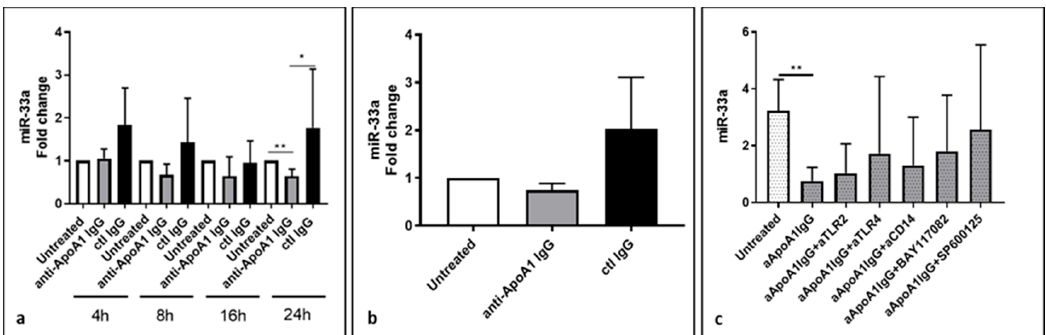
Figure 1. Lower levels of intracellular and extracellular miR-33a in anti-ApoA-1 IgG-treated human macrophage. Cells were treated with anti-ApoA-1 IgG or control antibodies for 4, 8, 16, and 24 h and RT-PCR was performed to determine ( a ) intracellular miR-33a levels as well as ( b ) miR-33a in the supernatant counterpart after 24 h anti-ApoA-1 IgG or control IgG treatment. ( c ) Blocking antibodies againstTLR2 / 4 were used as well as inhibitors of NF-kB and AP-1 to investigate the anti-ApoA-1 IgG mediated miR-33a downregulation. In ( a , b ), data are expressed as fold change expression of the mean ± SD of miR-33a calculated by ∆∆ CT method of five independent experiments ( n = 5) and values were normalized to untreated condition, while in panel ( c ), data are expressed as miR-33a quantity (2 − ∆∆ Ct ). p -values were calculated using Student’s t -test. Panel a, * p = 0.015, ** p = 0.0012. Panel b, the difference is not statistically significant, anti-ApoA-1 IgG vs. untreated p = 0.11, anti-ApoA-1 IgG vs. ctl control IgG p = 0.28. ( c ), ** p =